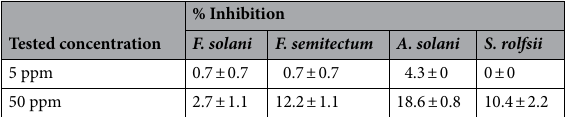
Table 8. Antifungal activity of biosynthesized iron nanoparticles.